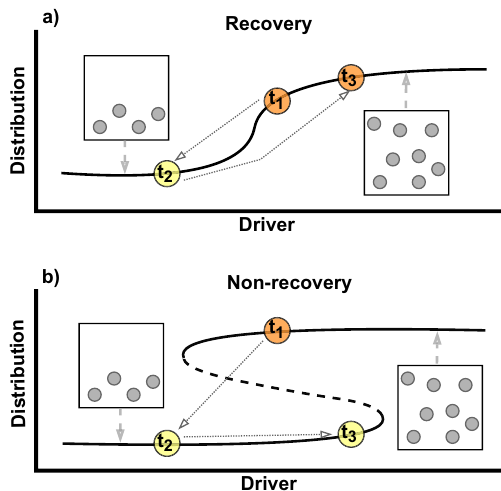
Figure 1. Conceptual diagram of spatial distribution recovery and non-recovery. The curved lines represent how an organism’s spatial distribution will change with an environmental driver where, ( a ) is a distribution that recover’s when the environmental driver returns to previous conditions and ( b ) is a distribution that does not recover when the environmental driver returns to previous conditions. The S-shape in ( b ) represents an unstable equilibrium between distributional states, where a distribution above the dashed line will be driven to the upper asymptote and distributions below the dashed line will be driven the lower asymptote (similar to the concept of hysteresis in ecosystem states 70 ). The colored circles on the lines represent three snapshots in time (t 1 –t 3 ) that are meant to represent the same environmental driver conditions between panels a and b, and the dotted grey arrows represent the transition between each snapshot. The circles within boxes represent the snapshots of the spatial states for the organism’s distribution. Figure made using the software diagrams (diagrams.net).